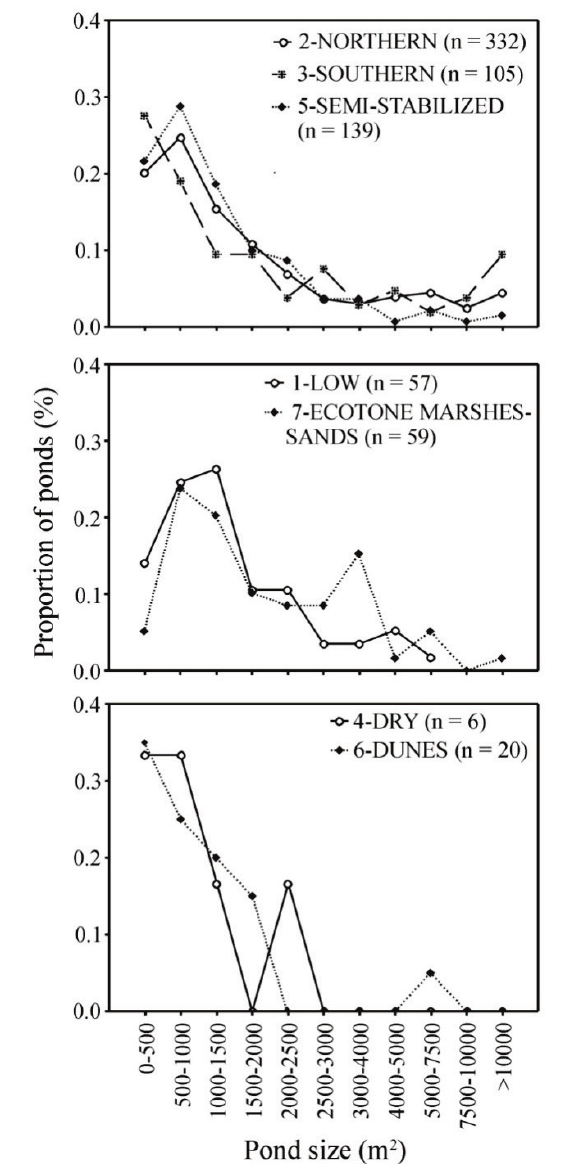
Figure 4. Distribution pattern of temporary ponds size in each ecosection at the largest flood event in the study area (February 15th,